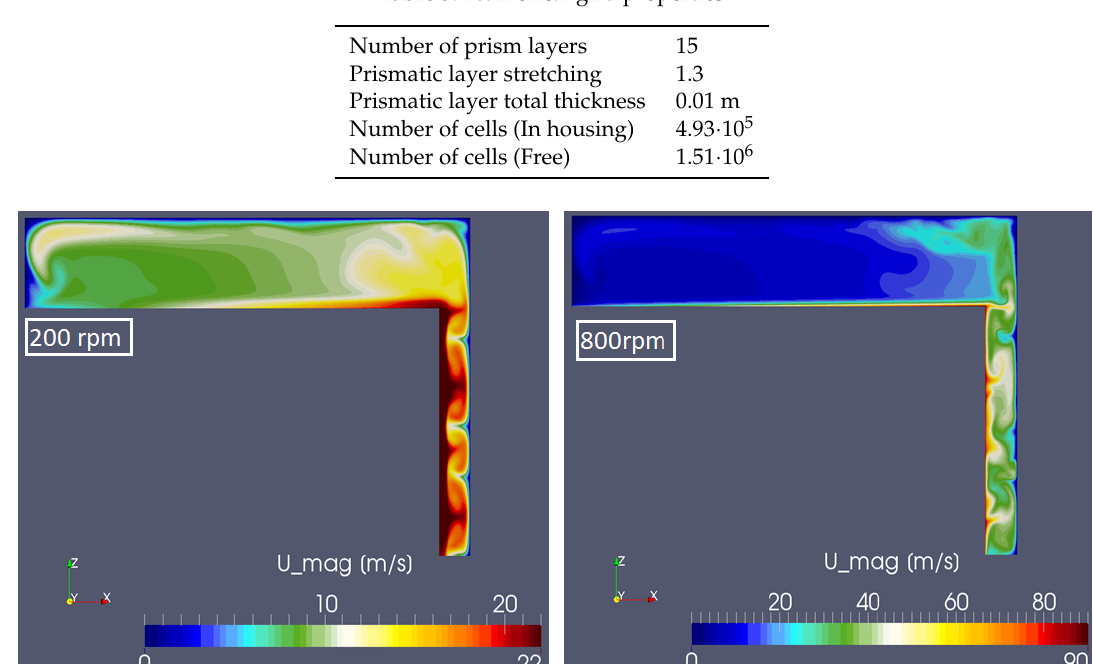
Table 5. Numerical grid properties.